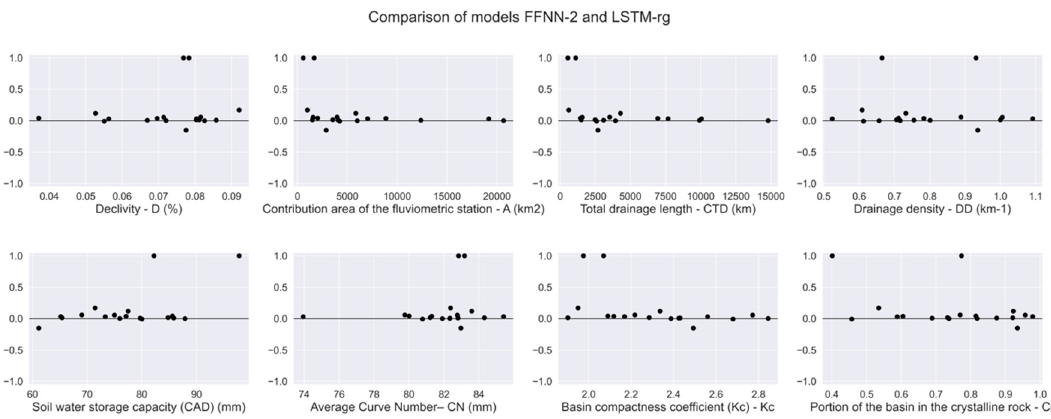
Figure 10. The y-axis represents the logarithm of the ratio of the NSE index of the FFNN-2 over the NSE index from the LSTM-rg model for each basin’s characteristics used in this study